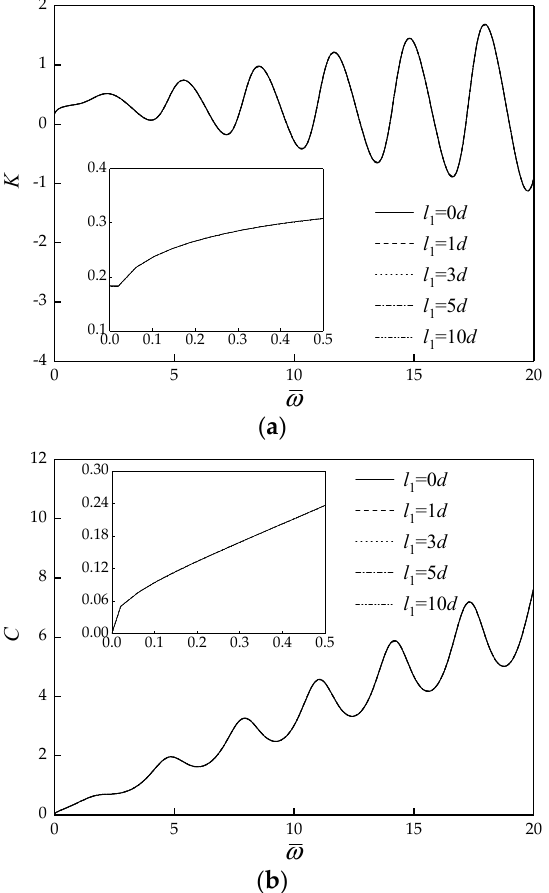
Figure 6. Effect of thickness of soft subsoil on the vertical dynamic impedance of pile. ( a ) Dynamic stiffness curves; ( b ) Dynamic damping curves.